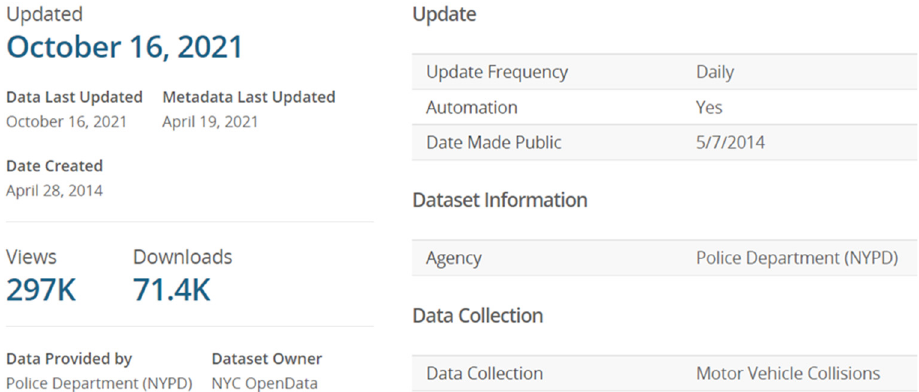
Figure 2. Description of the employed dataset.